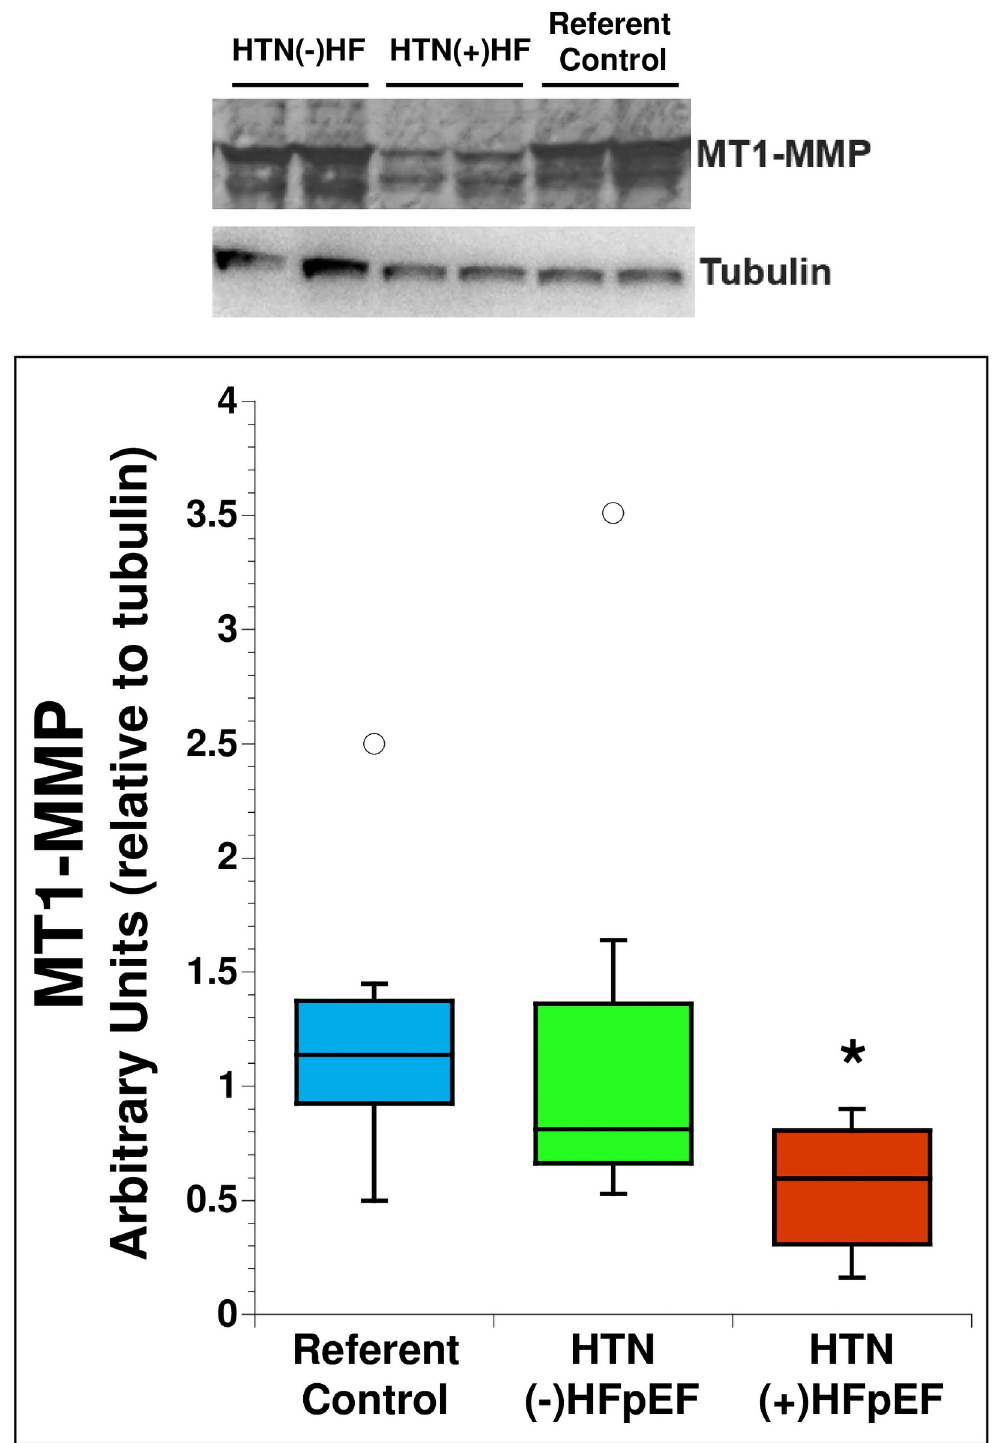
Fig 5. MT1-MMP production by primary fibroblasts was quantified by immunoblot analysis and determined relative to expression of tubulin. A representative blot of MTI-MMP in cell layers is shown. Protein production was evaluated in cells from P2 or P3. Blue: Referent control (n = 8), Green: HTN (-) HFpEF (n = 7), Red: HTN (+) HFpEF (n = 12). � p < 0.05, open circles represent outlier